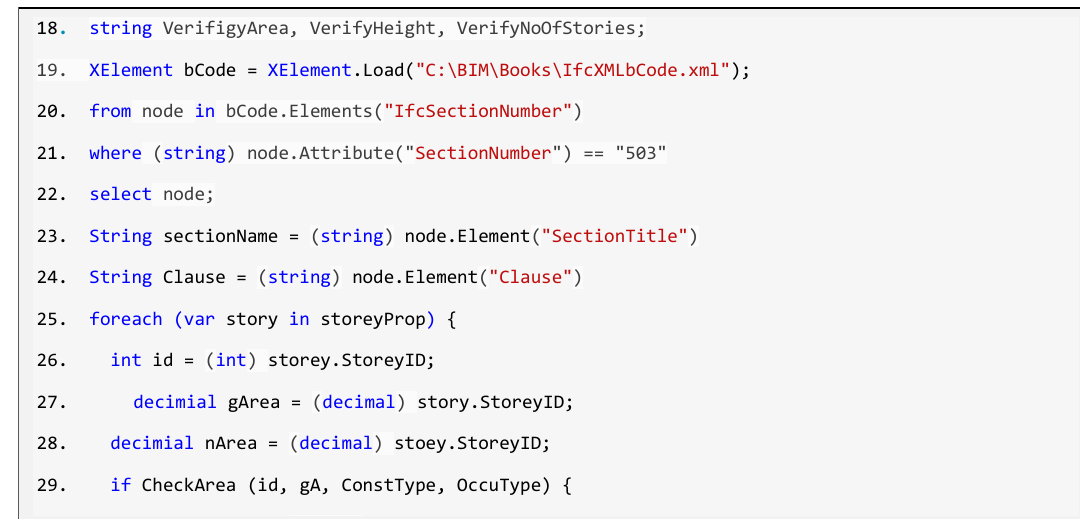
Figure 10. Main Ifc objects referenced in the example.